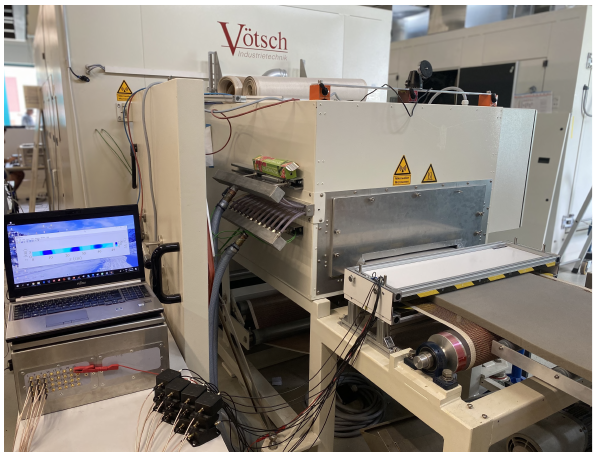
Figure 3. The ECT sensor installed at the exit of the microwave oven. After the drying process, the foam enters and passes through the ECT sensor while the ECT estimates its moisture